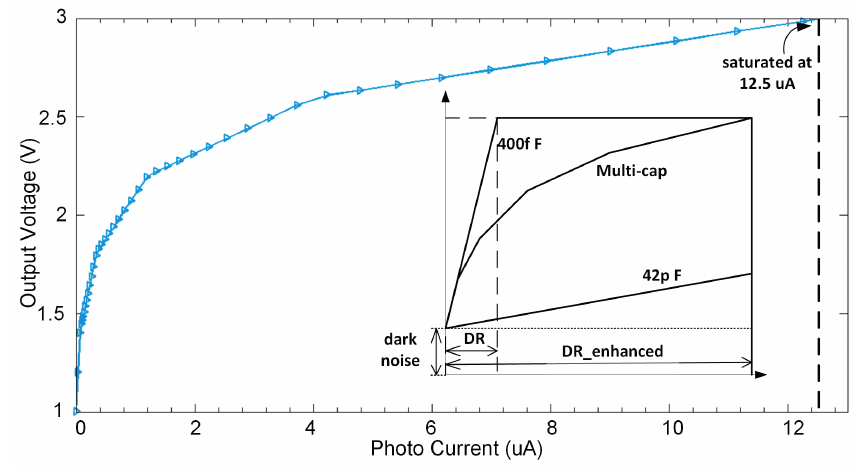
Figure 13. Output voltage versus photocurrent. The pixel saturates at around 12.5 μ